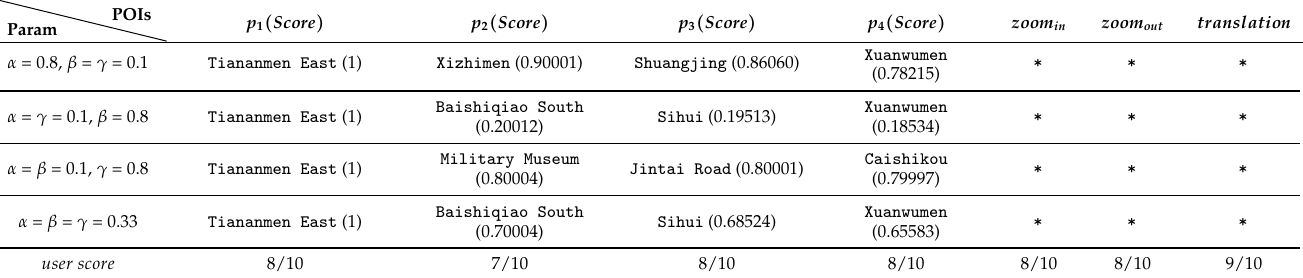
Table 4. Experiment score and user